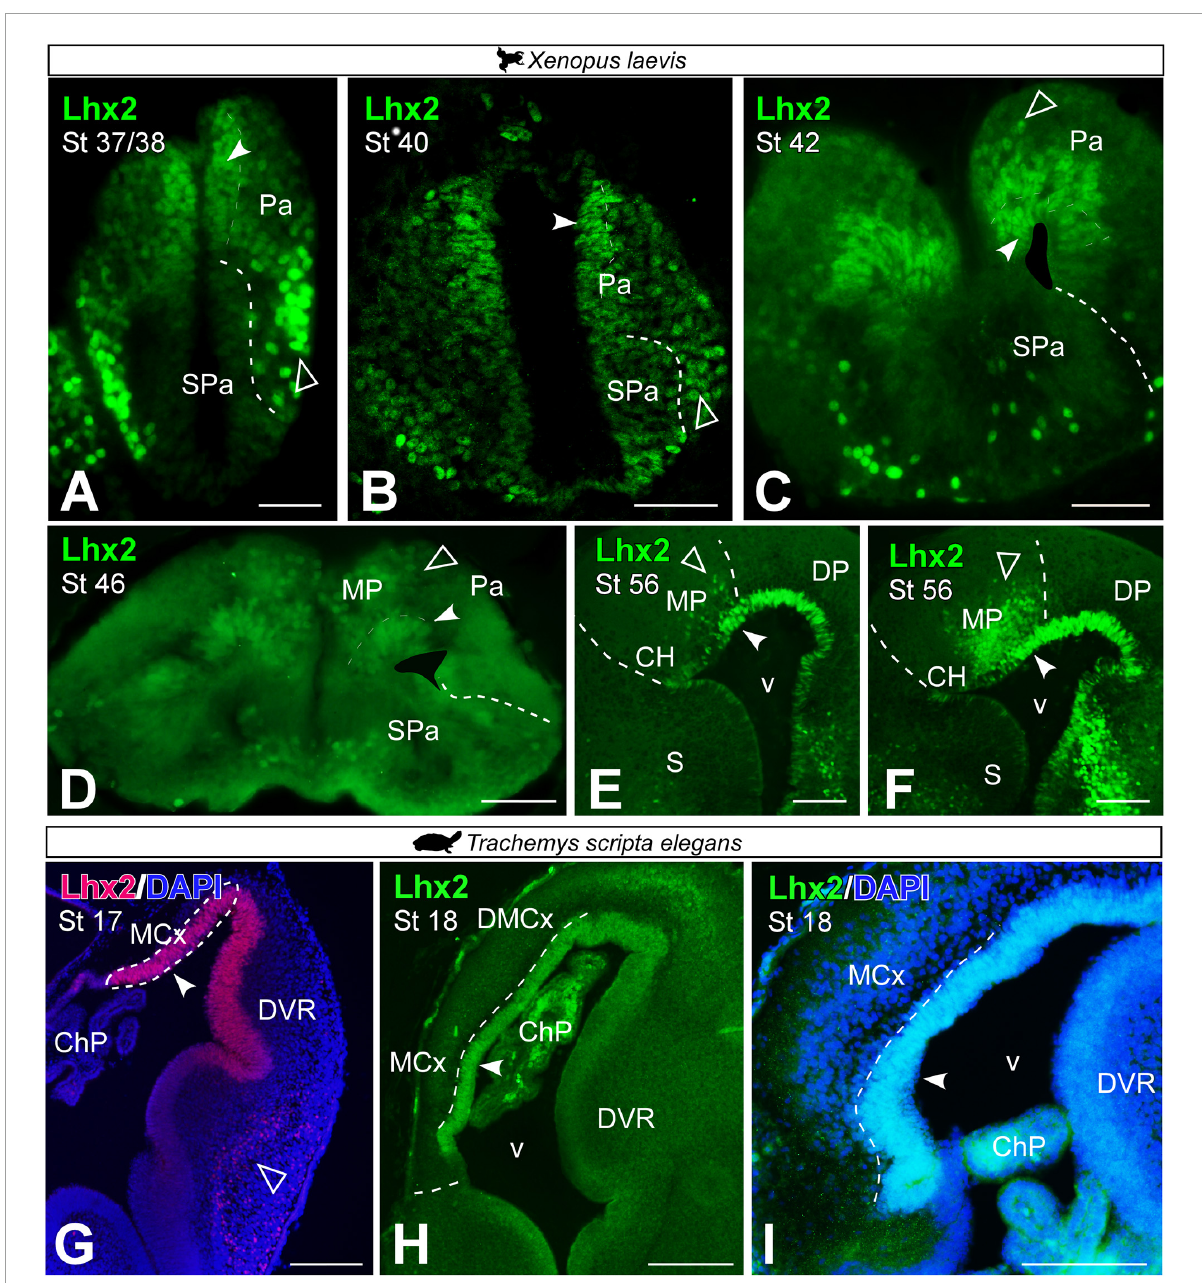
FIGURE4 Photomicrographs of transverse sections through the telencephalon of Xenopus laevis (A–F) and Trachemys scripta elegans (G–I) of Lhx2 expression in the medial pallium at embryonic (A–C,G–I) and early (D) and late larvae stages (E,F) . In each panel the developmental stage is indicated. Filled arrowheads point to ventricle expressing cells and empty arrowheads to mantle expressing cells. Scale bar (A–H) = 200 µ m and (I) = 100 µ m. See the abbreviation